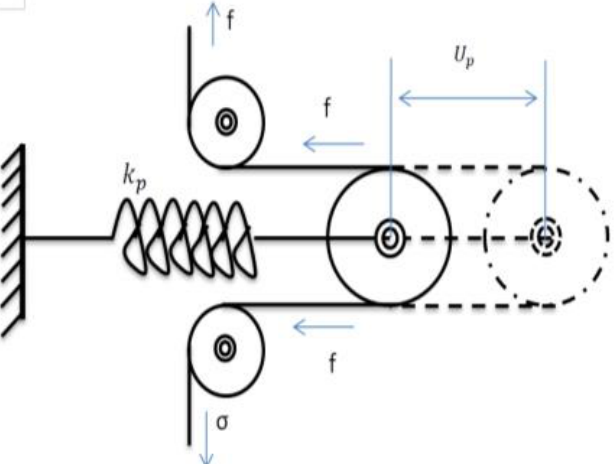
Figure 18. Pretension mechanism structure.